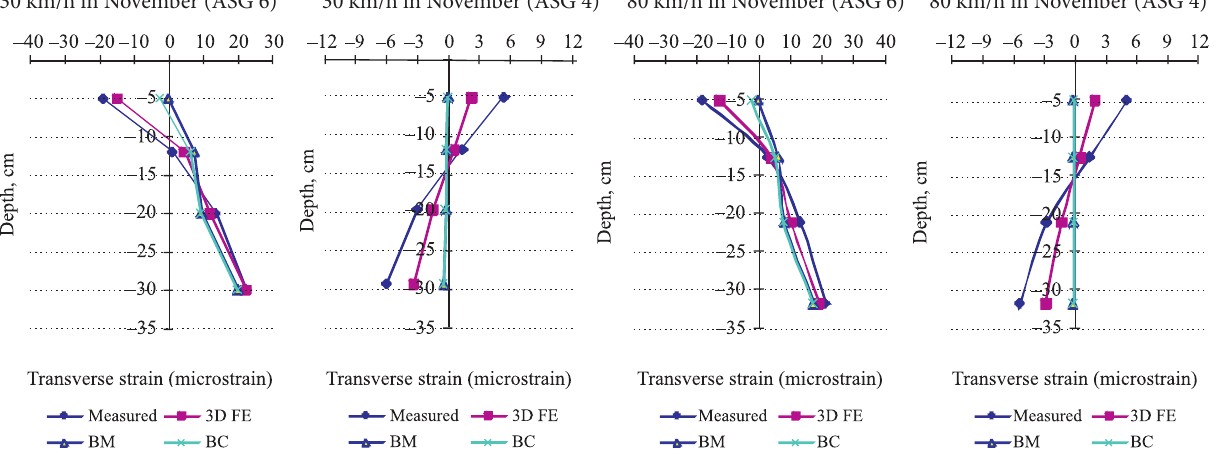
Fig. 8. Comparisons of the measured transverse strains and predicted transverse